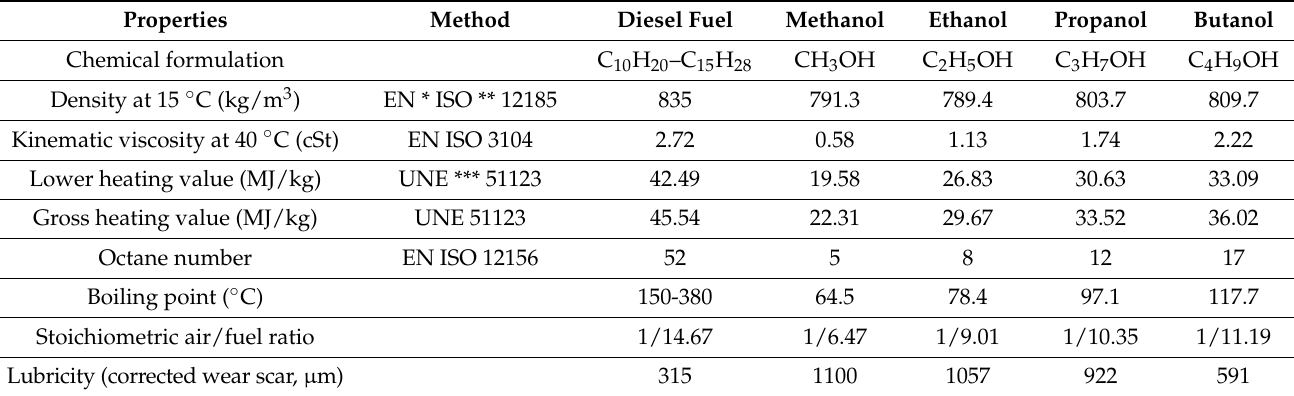
Table 1. Physiochemical characteristics of diesel fuel and commonly used alcohols to fuel diesel engines [12,13]. Properties